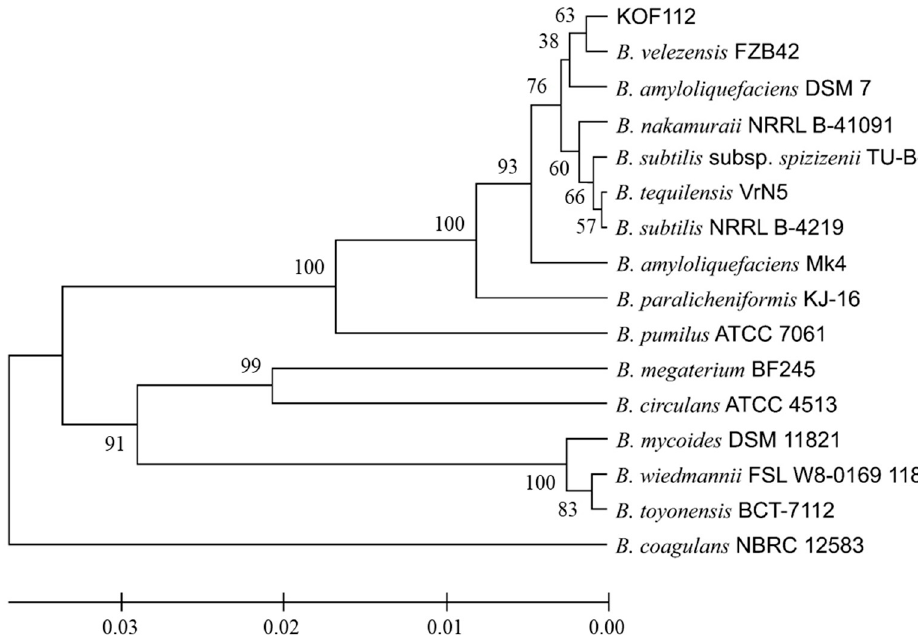
Figure 2. Phylogenetic analysis of 16S rDNA nucleotide sequence of KOF112 compared with those of Bacillus isolates. A phylogenetic tree was designed by means of the neighbor-joining (NJ) method using MEGA X program (bootstrap value with 1000 replicates). Bar indicates 1% band dissimilarity. Distance corresponds to the number of nucleotide substitutions per site. B. velezensis FZB42 (acces- sion no. CP000560). B. amyloliquefaciens DSM7 (accession no. FN597644). B. amyloliquefaciens Mk4